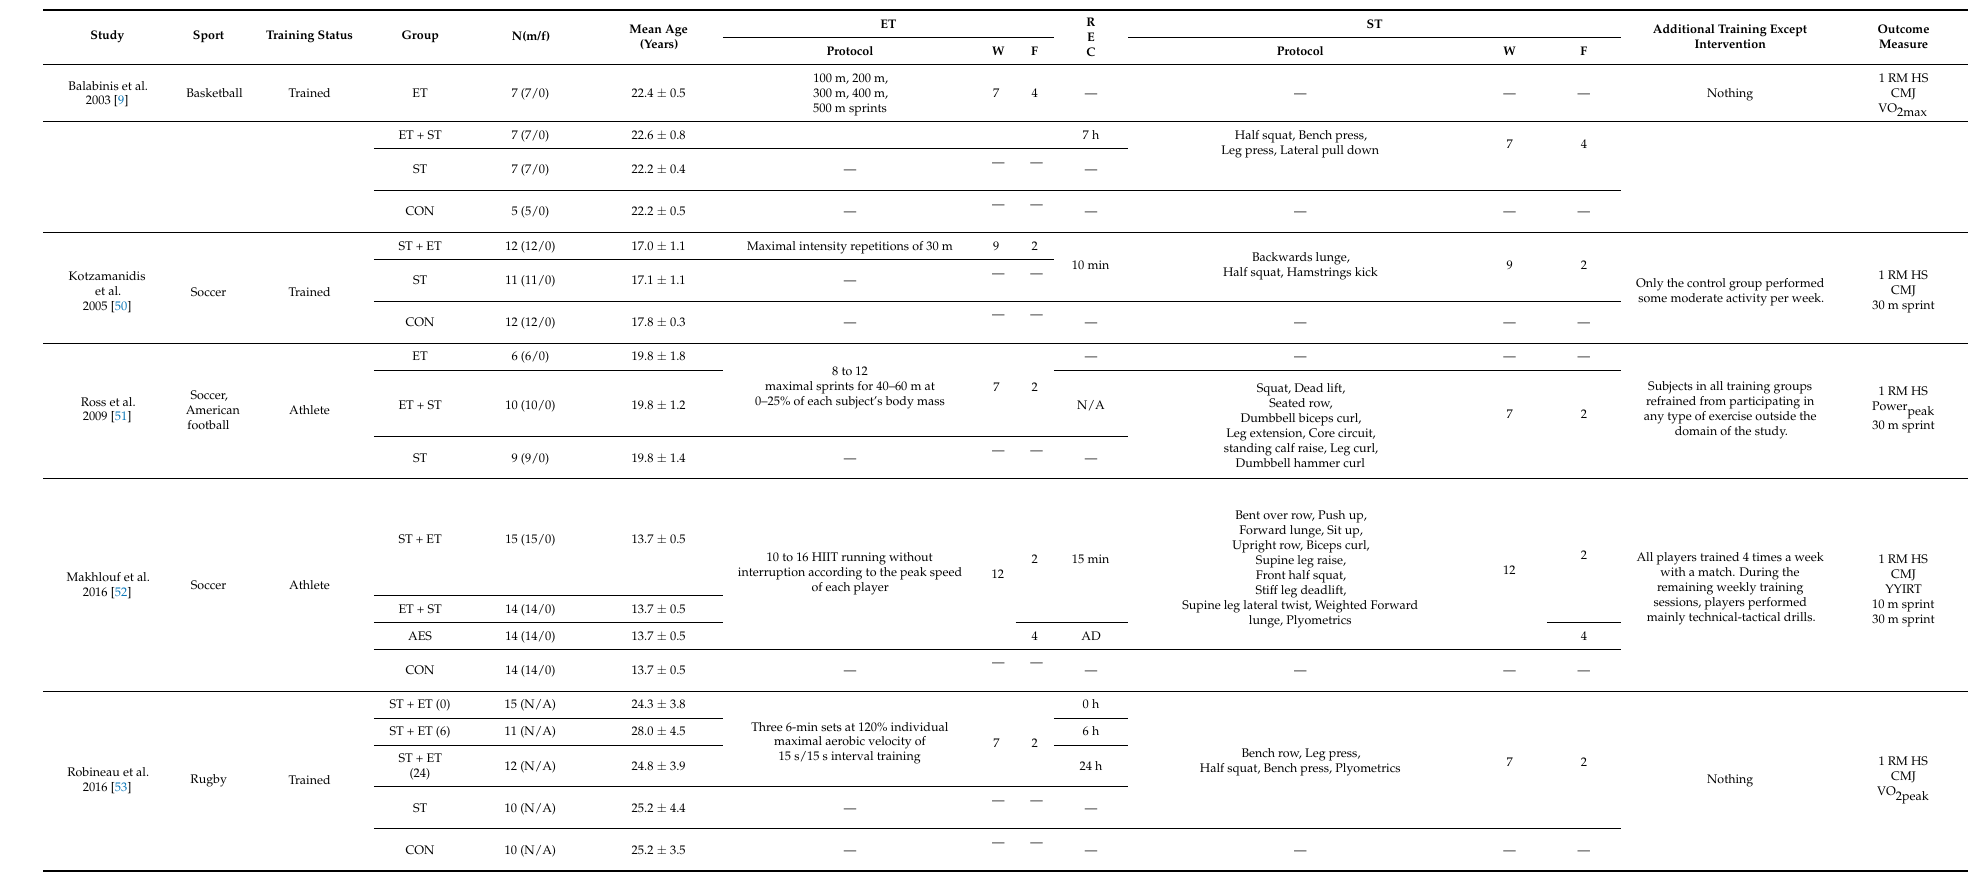
Table 3. Characteristics of the studies included in the meta-analysis.